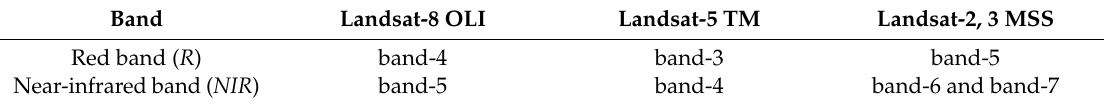
Table 2. Red band and near-infrared band in Landsat-8, -5, and -2, 3.